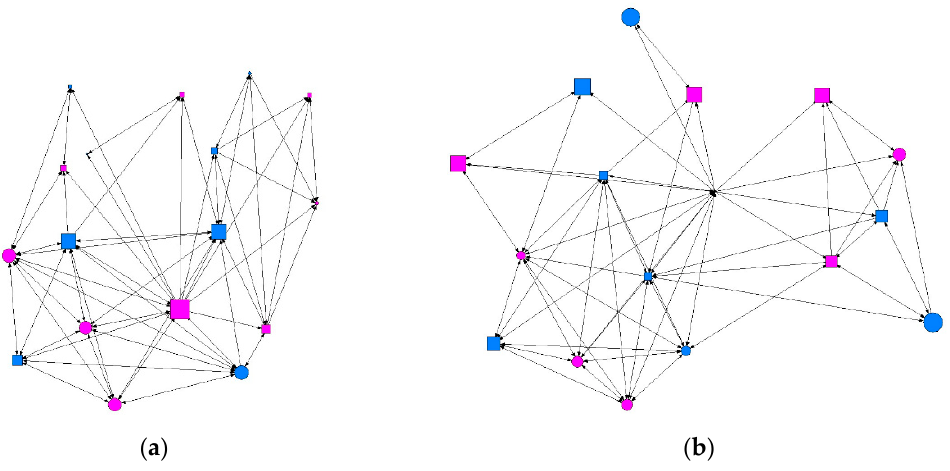
Figure 2. Graph of minimum contact intensity in a class. Males are shown in blue and females in pink; circles represent individuals whose consumption did not present a risk and squares represent individuals showing at-risk use. Graphs produced using UCINET software [48]: ( a ) where the size of the nodes indicates the degree of prestige or influence (eigenvector); ( b ) where the size of the nodes indicates the degree of proximity (closeness).